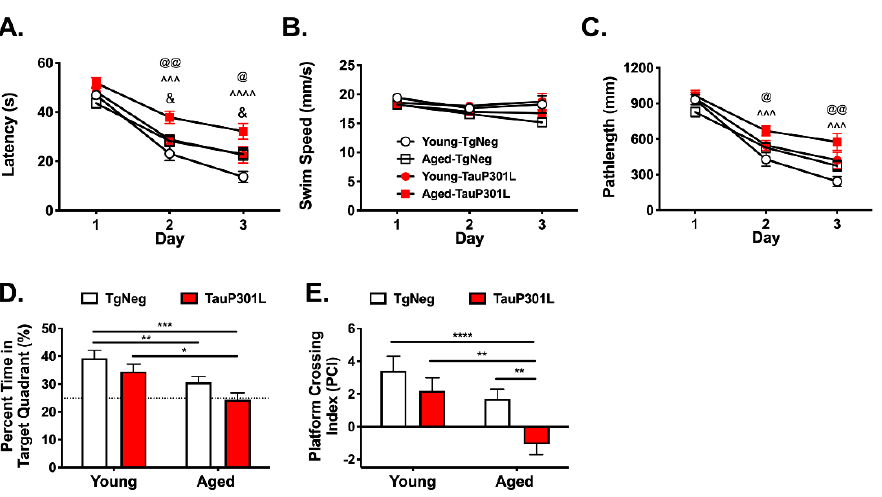
Figure 2. Aged-P301L mice exhibit deficits in the Morris water maze. Performance in hidden platform training was assessed by comparing ( A ) latency, ( B ) swim speed and ( C ) pathlength. Probe trial performance was assessed using percent time in the target quadrant ( D ) and platform crossing index ( E ). @ represents significant difference between Aged-TgNegs and Aged-P301Ls; ^ represents significant difference between Young-TgNegs and Aged-P301Ls; & represents significant difference between Young-P301Ls and Aged-P301Ls. * /@/^/& p < 0.05, ** /@@/^^/&& p < 0.01, *** /@@@/^^^/&&& p < 0.001, **** /@@@@/^^^^/&&&& p < 0 .0001; n = 12 – 22/group.